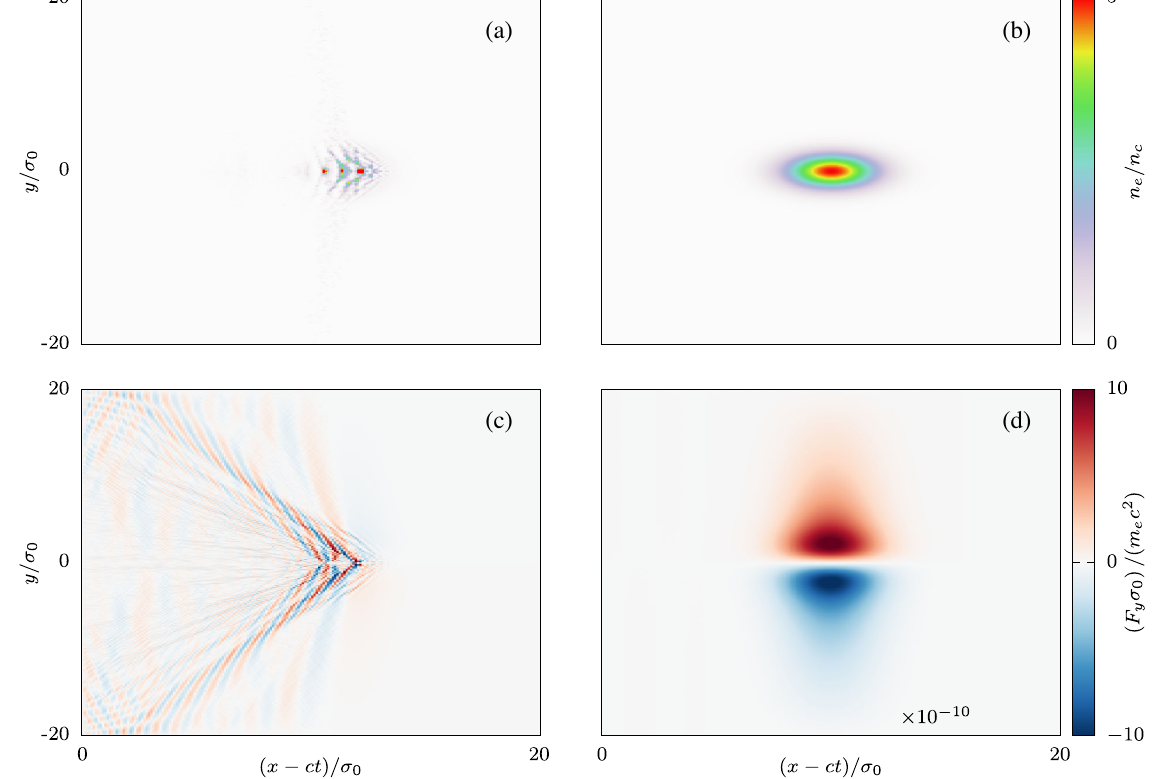
FIG. 4. Ultrarelativistic electron bunch propagating in vacuum with RR. The normalized electron density in n e =n c and the transverse force in dimensionless unit ð F y σ 0 Þ = ð m e c 2 Þ are shown after t=T b ¼ 10 . (a) and (c) show the data of the Yee solver and (b) and (d) the RIP solver. RR force is enabled in both simulations. The peak density of the data produced with the Yee solver increases to n e ≈ 11 . 96 n c